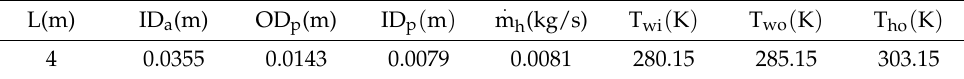
Table 5. Heat exchanger specification.